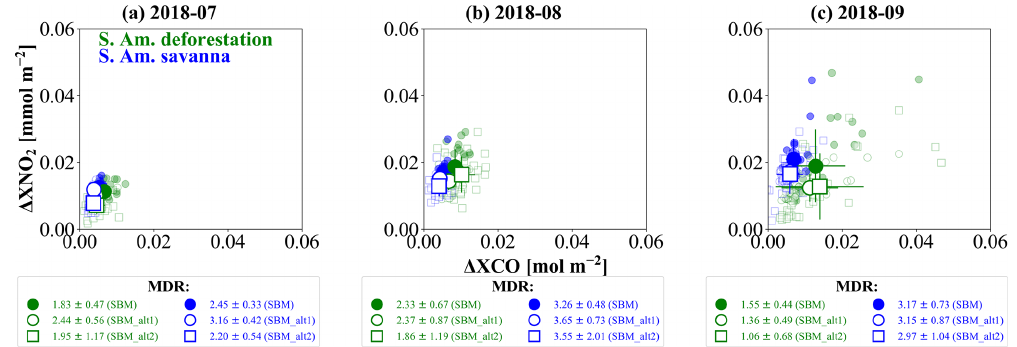
Figure 8. The relationship between daily (cid:49)X CO (molm − 2 ) and (cid:49)X NO 2 (mmolm − 2 ) from TROPOMI for the South American deforesta- tion (green) and savanna (blue) region for 3 consecutive months in 2018: July in panel (a) , August in panel (b) and September in panel (c) . For each month estimates are shown for three different sampling methods: SBM (solid circles), SBM_alt1 (open circles), and SBM_alt2 (open squares). In addition, the monthly average relationship between (cid:49)X CO and (cid:49)X NO 2 is depicted by the bigger markers together with error bars to indicate the 1 σ day-to-day variability. The legend of each panel includes monthly average MDR and 1 σ day-to-day variability estimates for each region and sampling